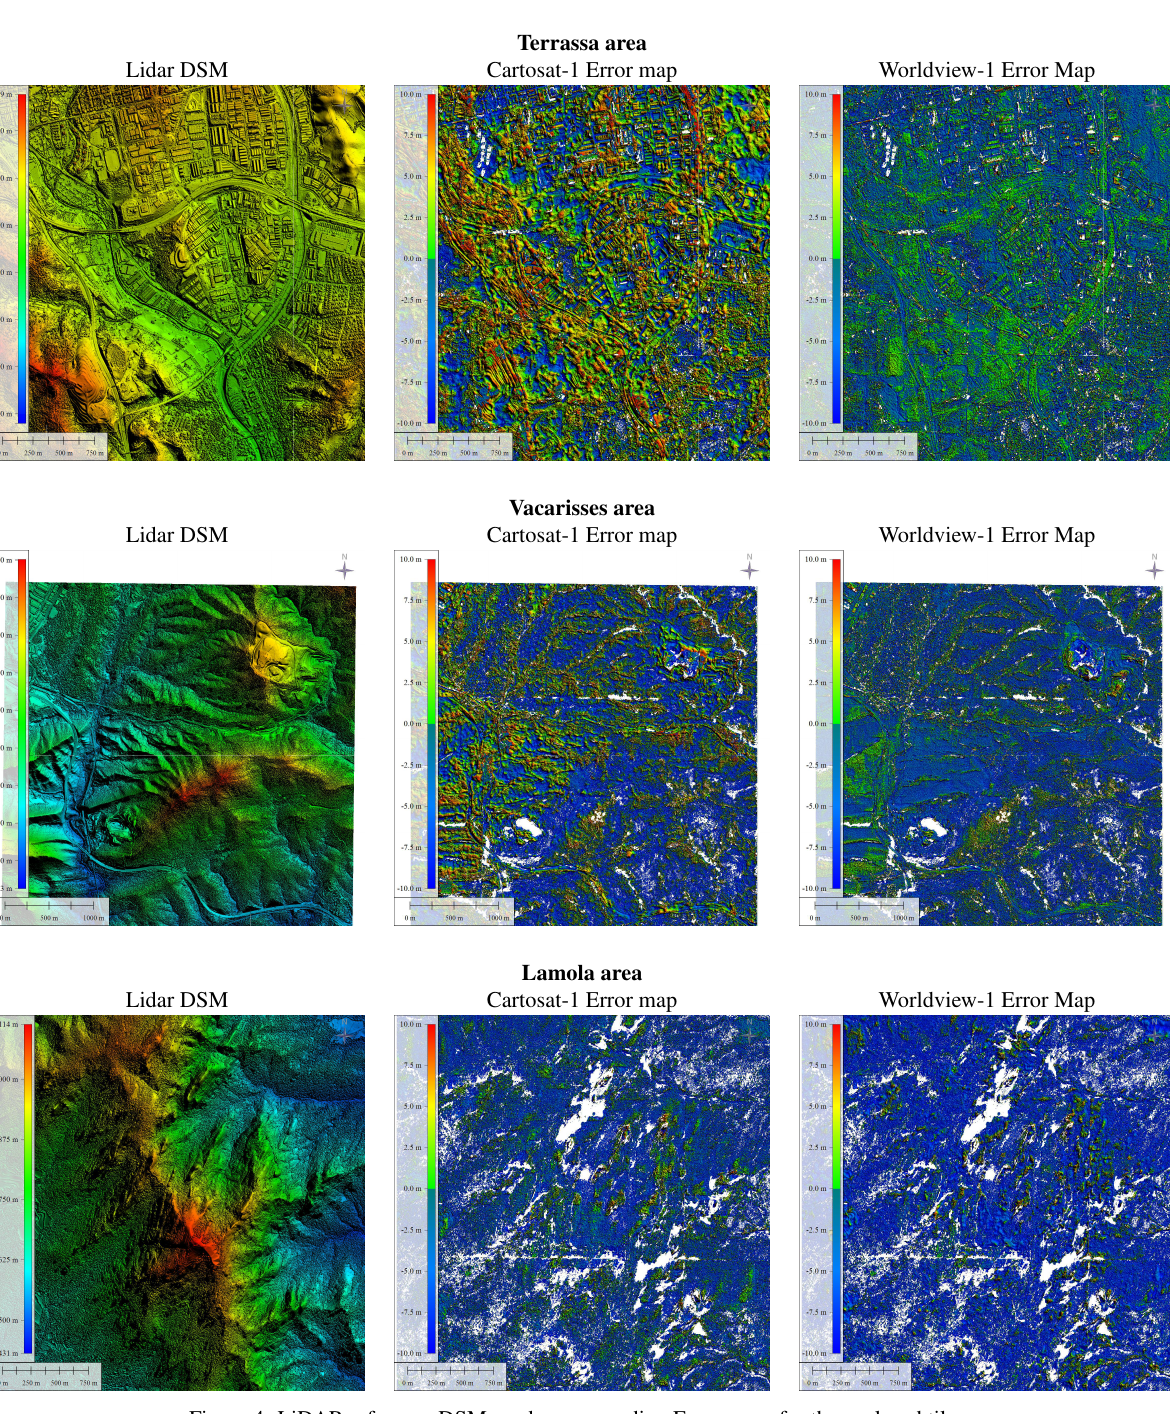
Figure 4: LiDAR reference DSMs and corresponding Error maps for the analysed